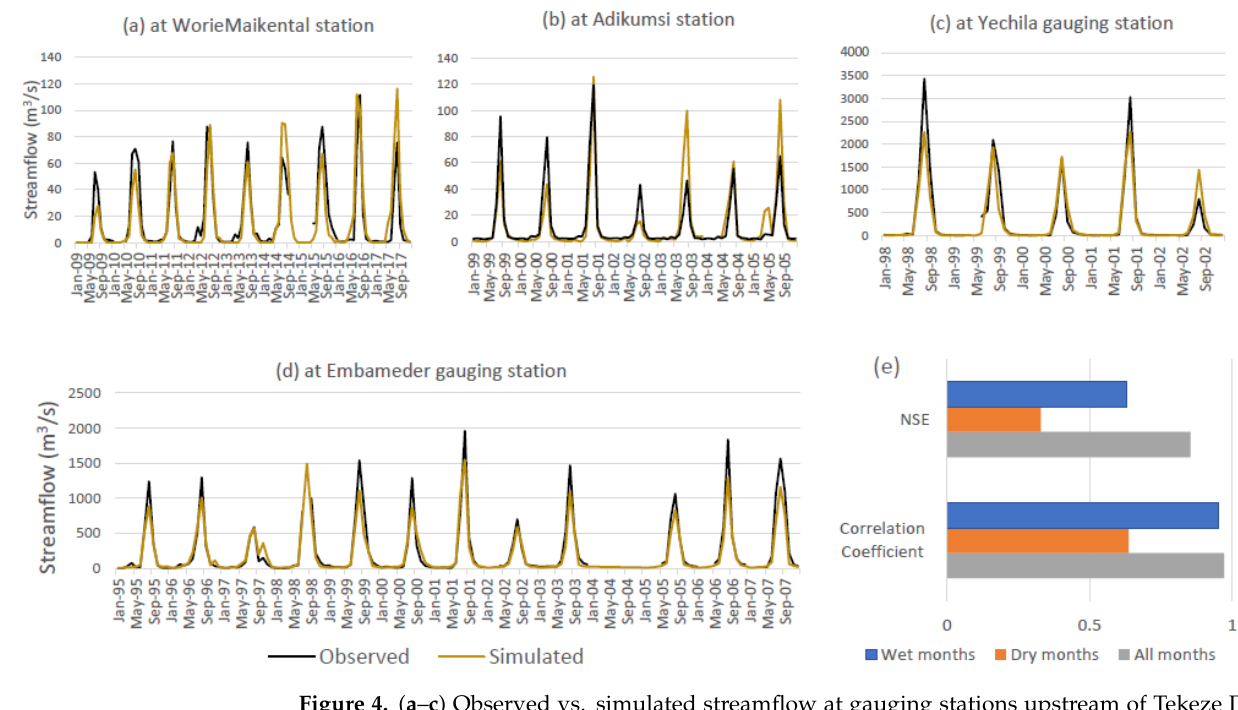
Figure 4. ( a – c ) Observed vs. simulated streamflow at gauging stations upstream of Tekeze Dam, ( d ) observed vs. simulated streamflow at Embameder gauging station, ( e ) statistical measures of streamflow at Embameder gauging station for wet and dry months.